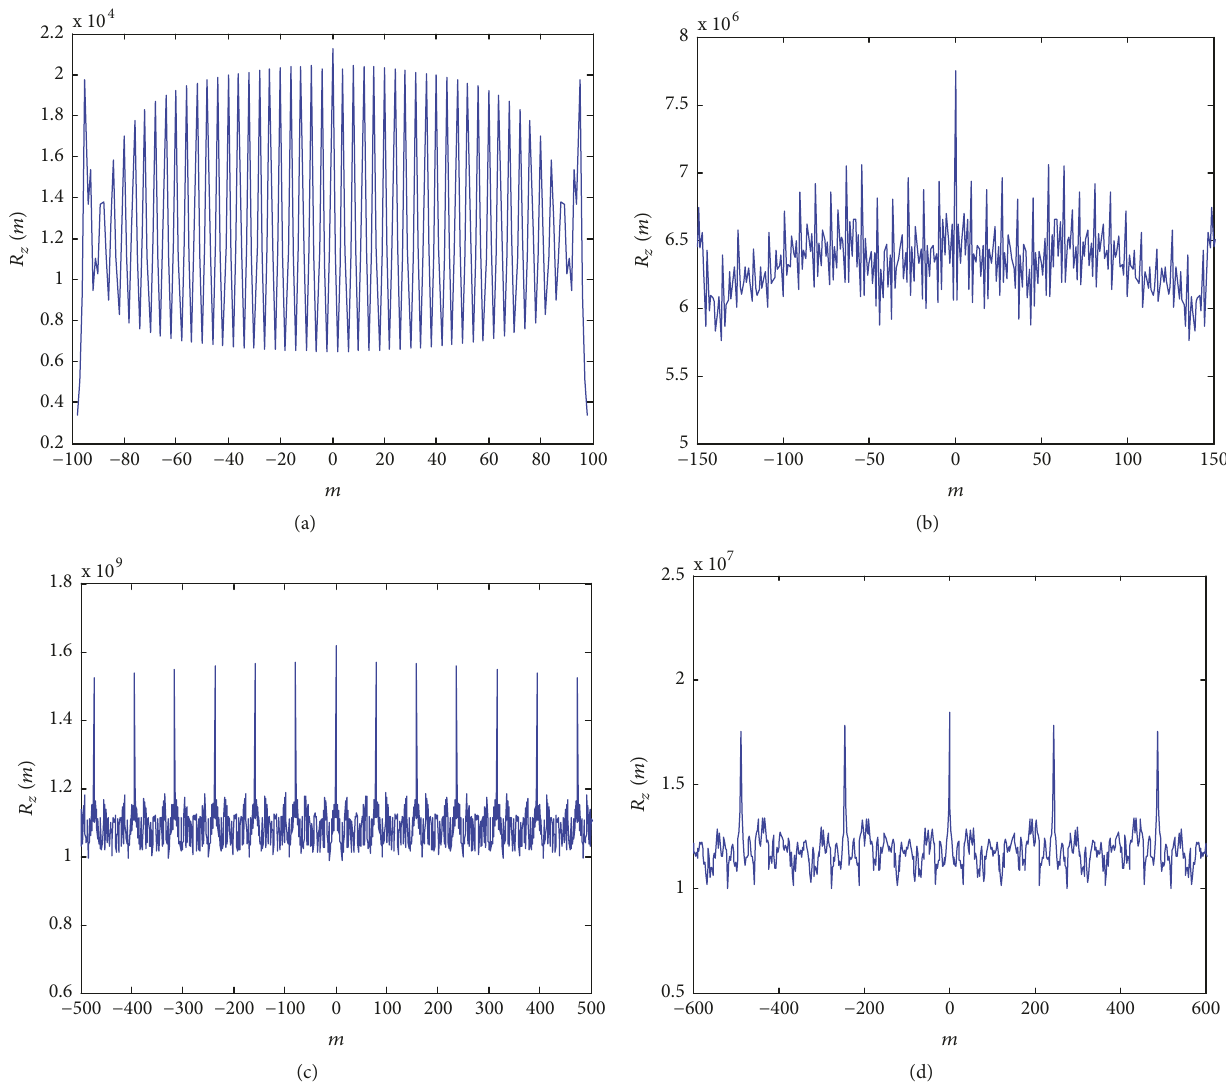
Figure 1: Autocorrelation test of Logistic chaotic sequences with different computational precision. (a) 𝐿 = 8 ; (b) 𝐿 = 12 ; (c) 𝐿 = 16 ; (d) 𝐿 = 24